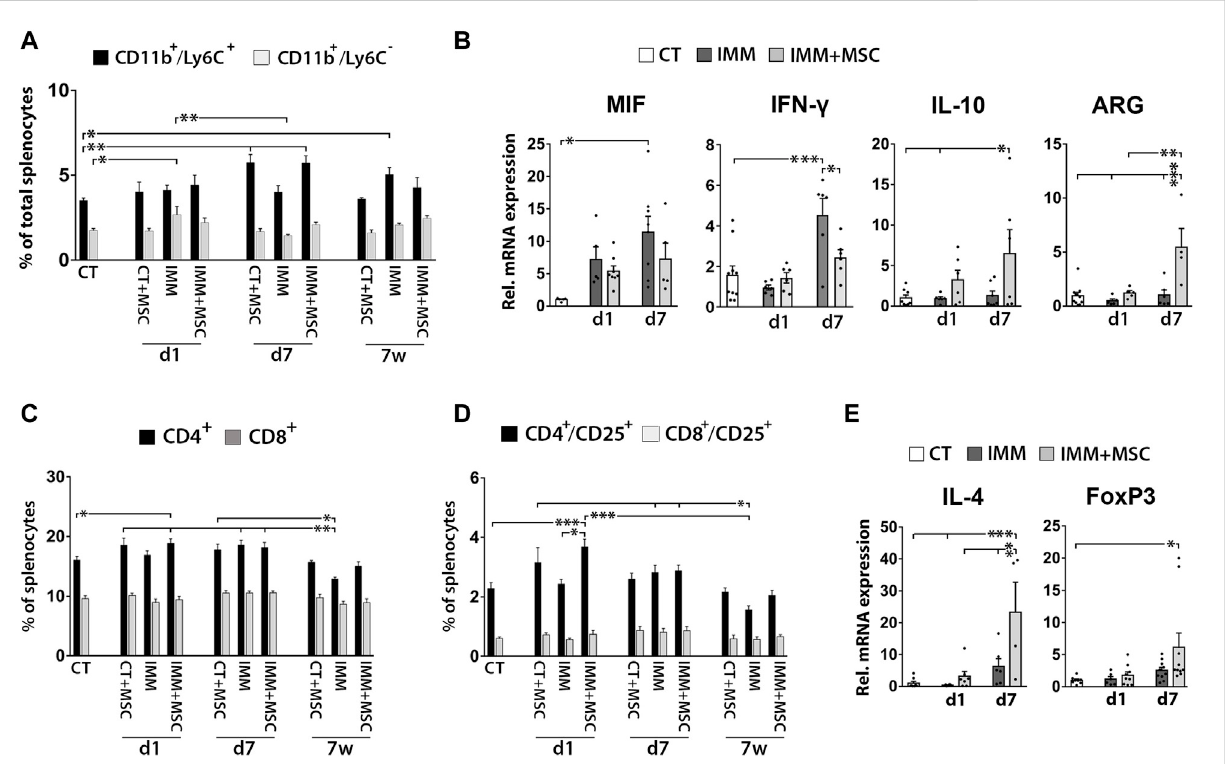
FIGURE 5 UC-MSC transplantation induces splenic anti-in fl ammatory and immunosuppressive responses in immunized RIP-B7.1 mice. (A) Quanti fi cation of splenic CD11b + /Ly6C − myeloid cells and CD11b + /Ly6C + myeloid-derived suppressor cells (MDSC). Note how both CT and IMM mice at 7 days post- transplantationdisplayincreasedsplenicpercentagesofCD11b + /Ly6C + MDSC. (B) Q-PCRquanti fi cationofMIF,IL-10andARG1mRNAexpression. (C – E) Splenocytes from UC-MSC transplanted IMM mice display increased percentages of total and activated CD4 + T Cells and higher expression of the associated regulatory T Cells markers IL-4 and forkhead box P3 (FoxP3), compared to CT mice. (C) Quanti fi cation of total splenic CD4 + and CD8 + T Cells percentages. (D) Quanti fi cation of total splenic activated CD4 + /CD25 + and CD8 + /CD25 + T Cells percentages. (A, C, D) Splenocytes were collected from CT and IMM RIP-B7.1 mice, at 24 h, 7 days and 7 weeks post-transplantation with vehicle or 5 × 10 5 UC-MSC. (E) Q-PCR quanti fi cation of interleukin-4 (IL-4) and FoxP3 mRNA expression. (B, E) Splenocytes collected from CT and immunized RIP-B7.1 mice transplanted with vehicle (IMM) or 5 × 10 5